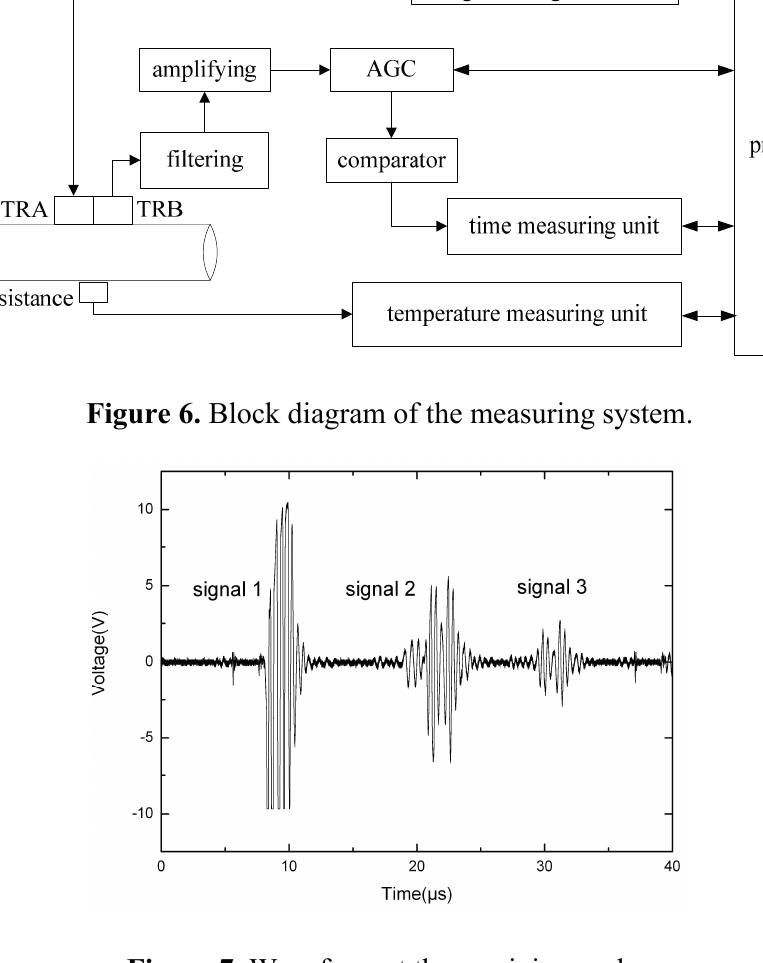
Figure 7. Waveform at the receiving probe.